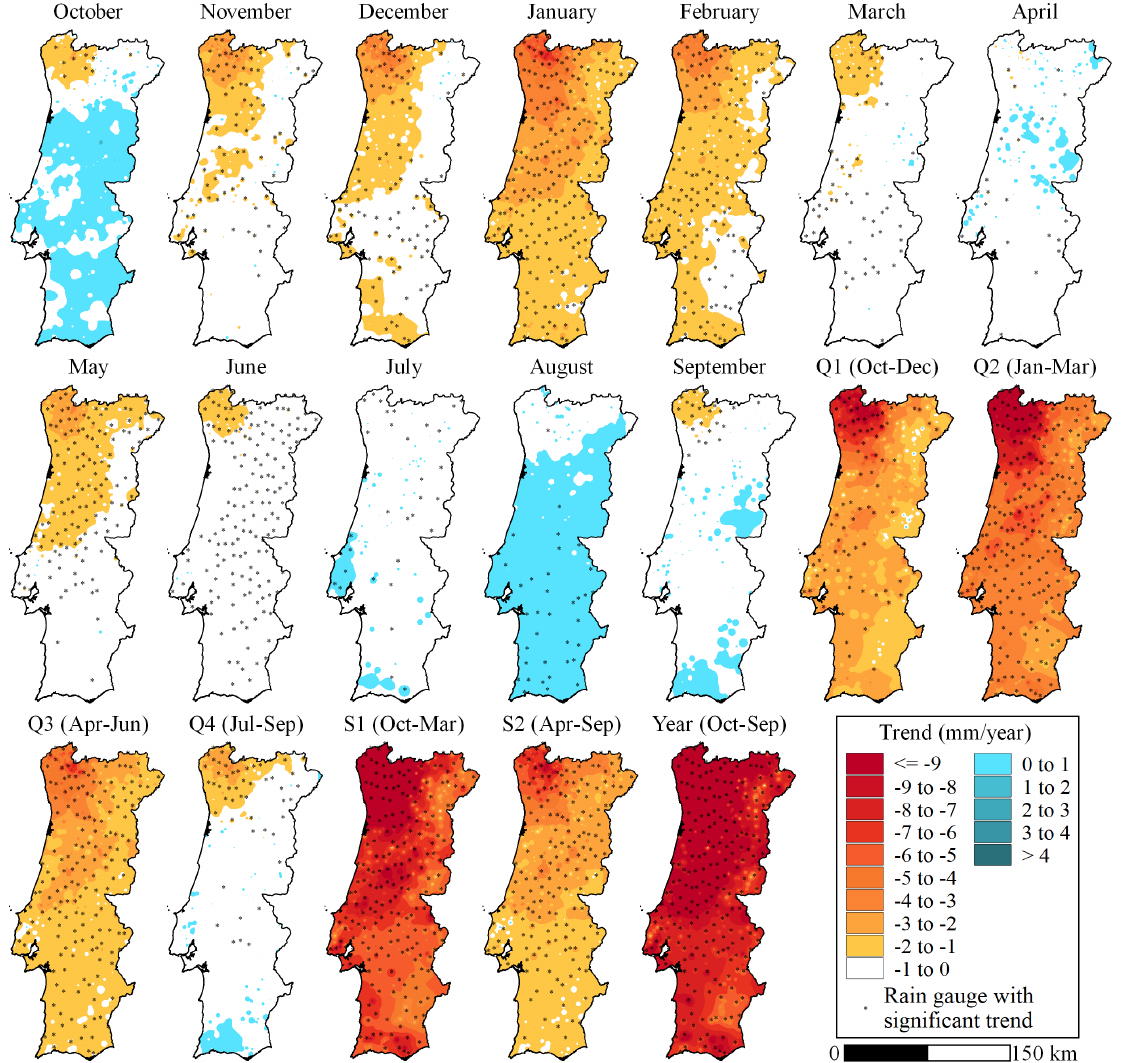
Figure 8. Spatial distribution of the Sen’s slope for the monthly, quarterly (Q1 to Q4), semi-annual (S1 and S2) and annual rainfall in the final sub-period, from 1968/1969 to 2018/2019 to (51 years). Only the rain gauges with significant trends are schematically located in the